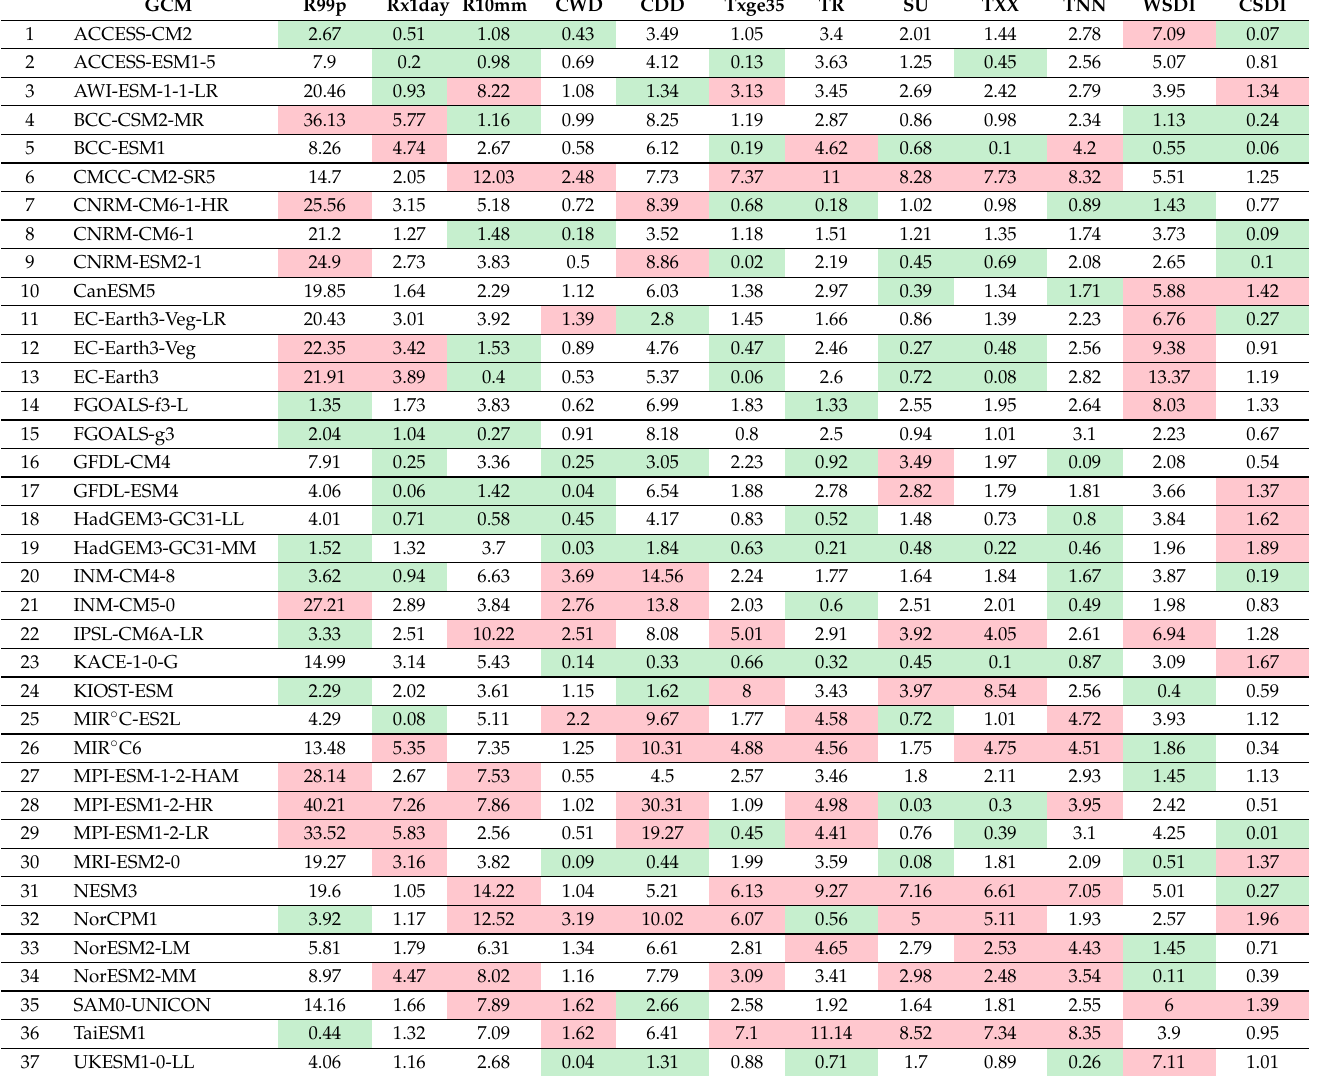
Table 3. Table of continentally averaged absolute bias recorded in 37 CMIP6 GCMs for the 12 extreme indices. A smaller value of bias corresponds to the better performance of GCMs. Here, the colour green and red denote the best (top 25% subset) and worst (bottom 25% subset) performing